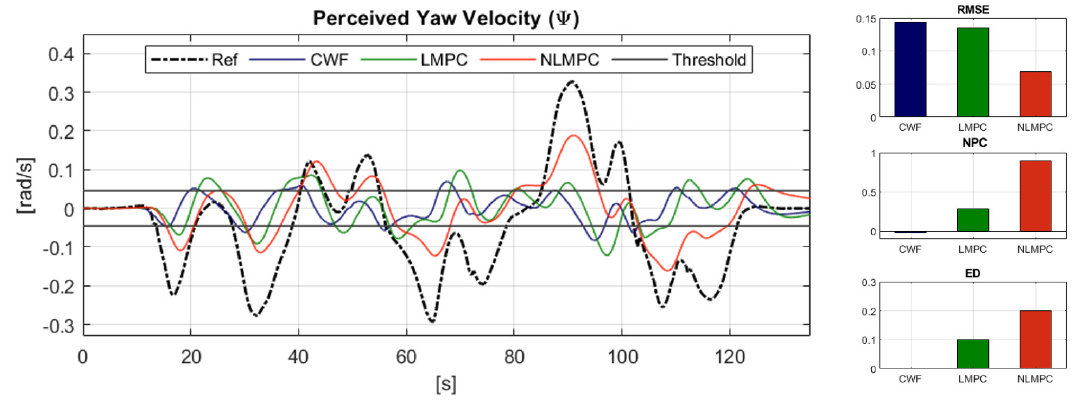
Figure 14. Reference Tracking performance: Perceived Yaw